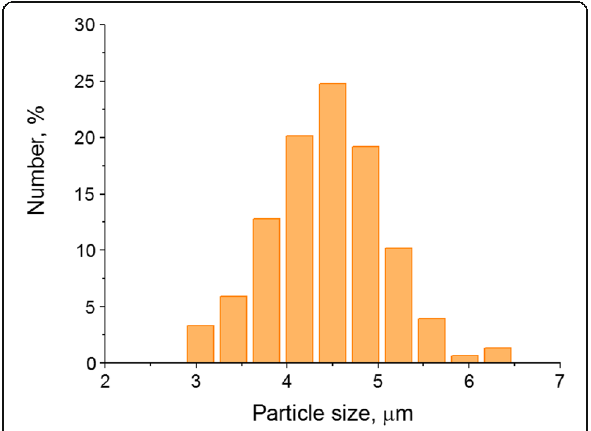
Fig. 2 Size distribution of the polyelectrolyte microcapsules optically encoded with quantum dots, where the number of the analyzed microcapsules was